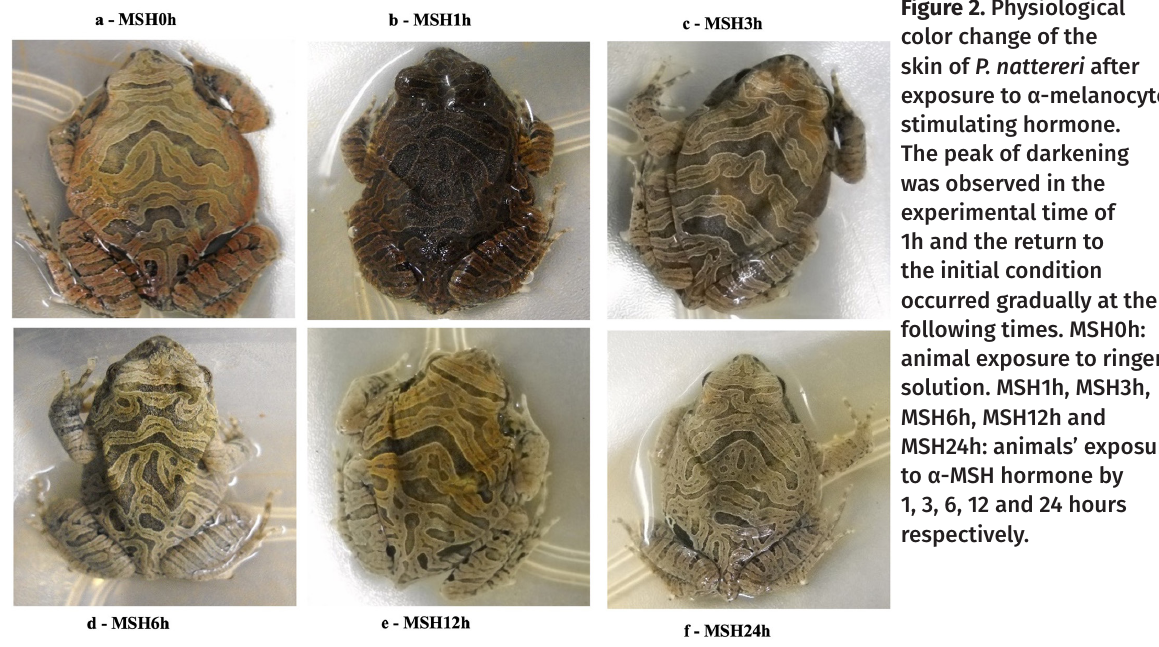
Figure 2. Physiological color change of the skin of P. nattereri after exposure to α-melanocyte- stimulating hormone. The peak of